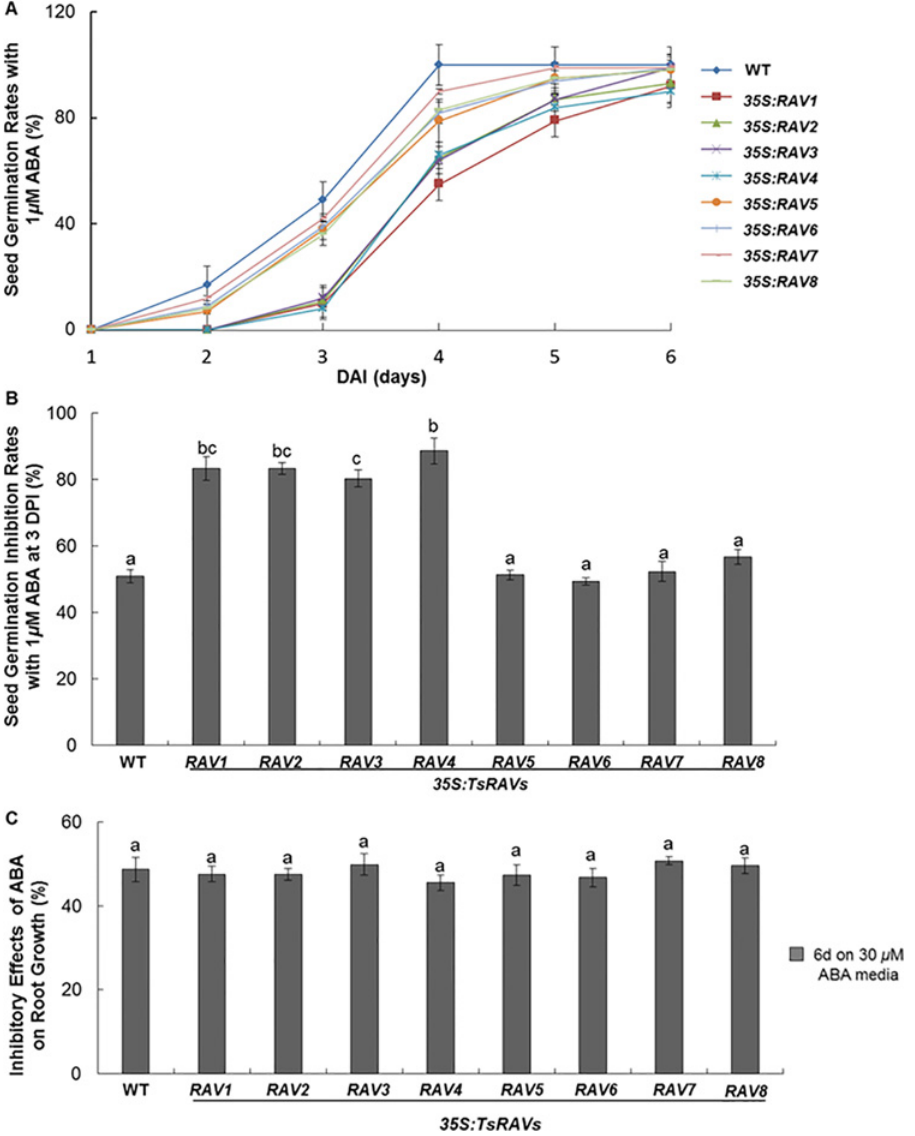
Fig 5. ABA sensitivity of 35S : TsRAVs transgenic Arabidopsis plants. (A) Germination rates of 35S : TsRAVs transgenic Arabidopsis seeds on 1/2 MS media with 1 μ M ABA. Each data bar represents the means ± SE of three replicates. More than 100 seeds were measured in each replicate. (B) Inhibitory effect of 1 μ M ABA on 35S : TsRAVs transgenic Arabidopsis seed germination rates. Each data bar represents the mean ± SE of three replicates. More than 50 seedlings were measured in each replicate. Different letters indicate significant differences among means ( P < 0.05 by Tukey ’ s test). (C) Inhibitory effect of 30 μ M ABA on 35S : TsRAVs transgenic Arabidopsis seedling root elongation. Seedlings were grown on normal media for 5 days before being transferred onto 1/2 MS medium with 30 μ M ABA and grown for other 6 days. Each data bar represents the mean ± SE of three replicates. More than 50 seedlings were measured in each replicate. Different letters indicate significant differences among means ( P < 0.05 by Tukey ’ s